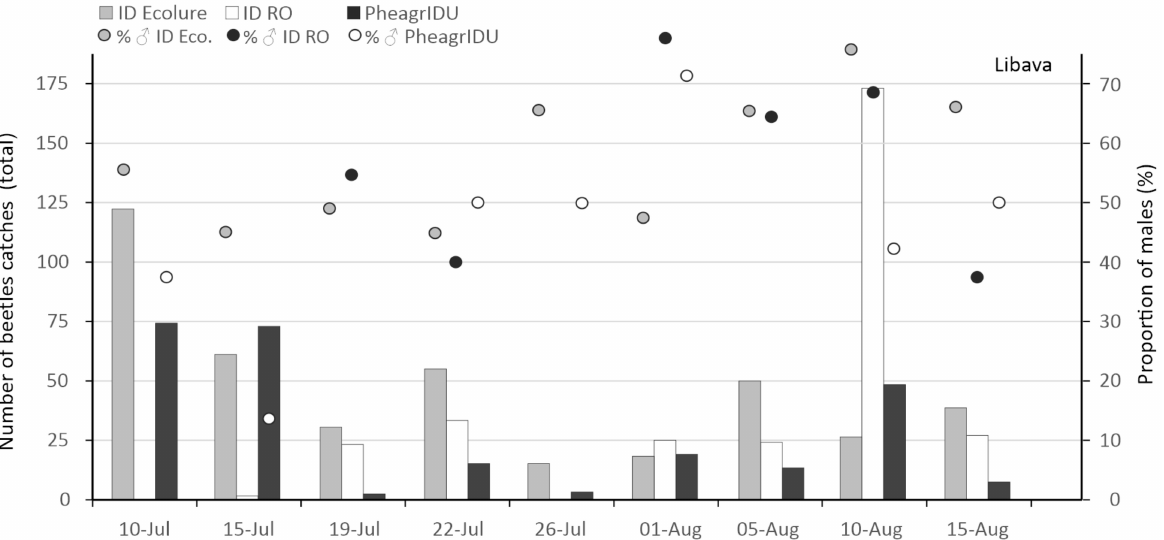
Figure 6. Trends in the dynamics of Ips duplicatus captures obtained at second field experiment (2017—Czech Republic) at traps baited with ID Ecolure, ID RO and Pheagr IDU dispenser types (mean captures: columns, reported at left Y axe, the proportion of males: dots, reported at right Y axe).